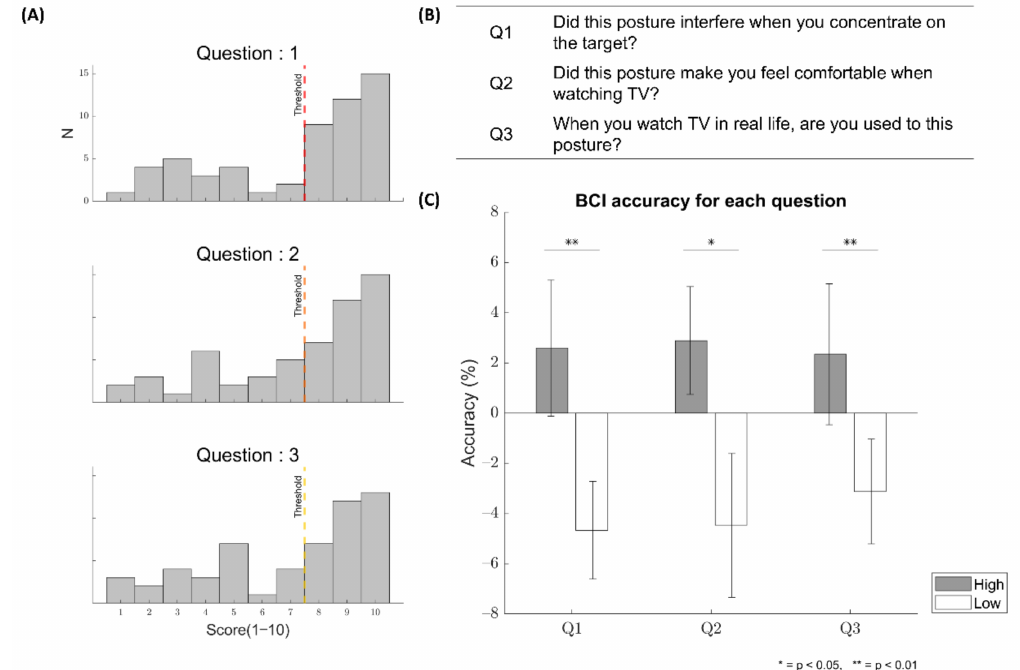
Figure 5. ( A ) The distribution of the scores (1–10) responded by subjects for each question. A threshold for each question was defined as the median score for the questions. N denotes the number of subjects. ( B ) Questions were asked to the subjects in the post-survey. ( C ) The average normalized BCI accuracy of the high-scoring group and low-scoring group for each question. The black vertical line denotes the standard error of the mean. * p < 0.05, ** p <